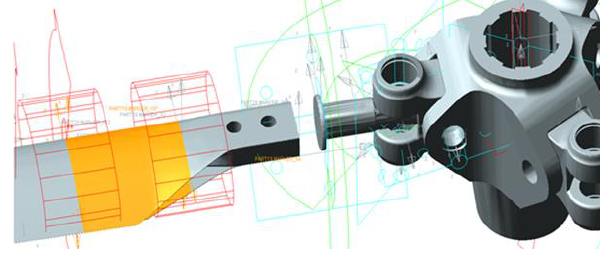
Fig. 2. The inertial system of the MBD model